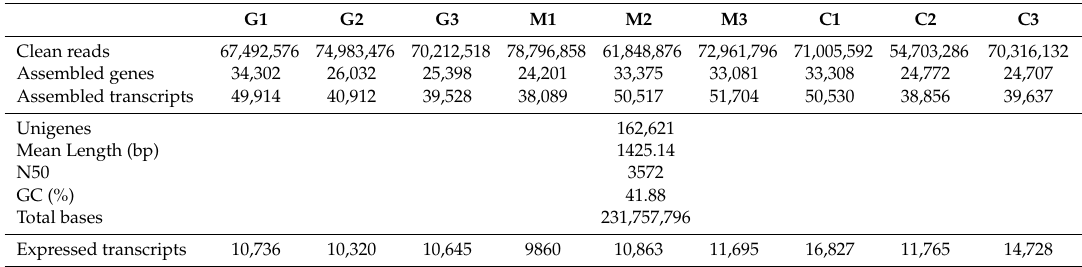
Table 1. Overview of the de novo transcriptome of